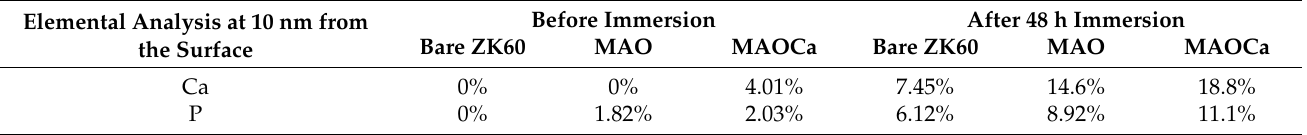
Table 2. XPS results for the bare ZK60 and MAO- and MAOCa-coated ZK60 plates before and after immersion in SBF solution.